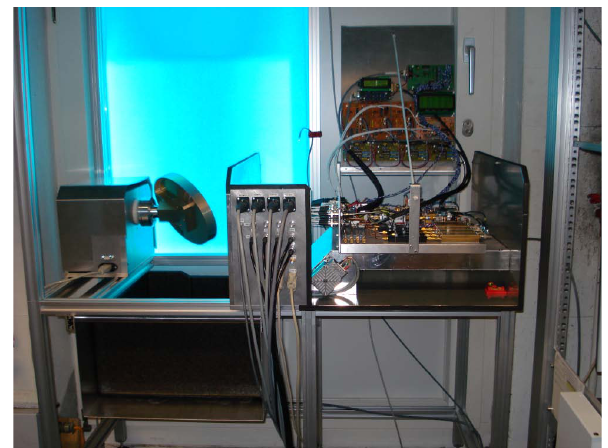
Fig. 2. TEMPERA with its main components, the frontend and the parabolic mirror. TEMPERA is 1.1m wide. The instrument is placed inside in a thermally controlled lab in front of a blue styro- foam window through which the atmosphere is